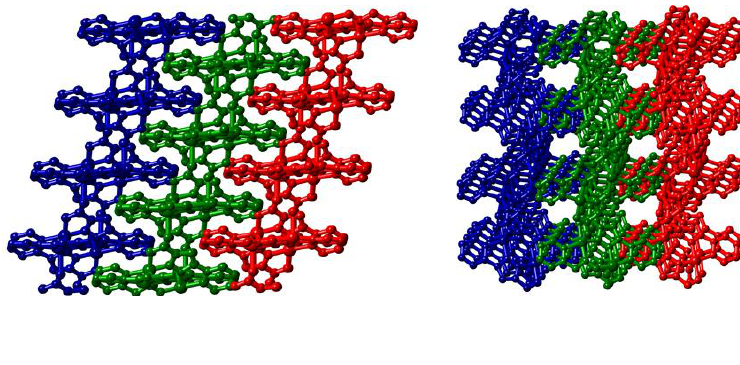
Figure 5. Representation of the packing of adjacent polymeric sheets in 2 . Independent networks are coloured separately. Hydrogen atoms are omitted for